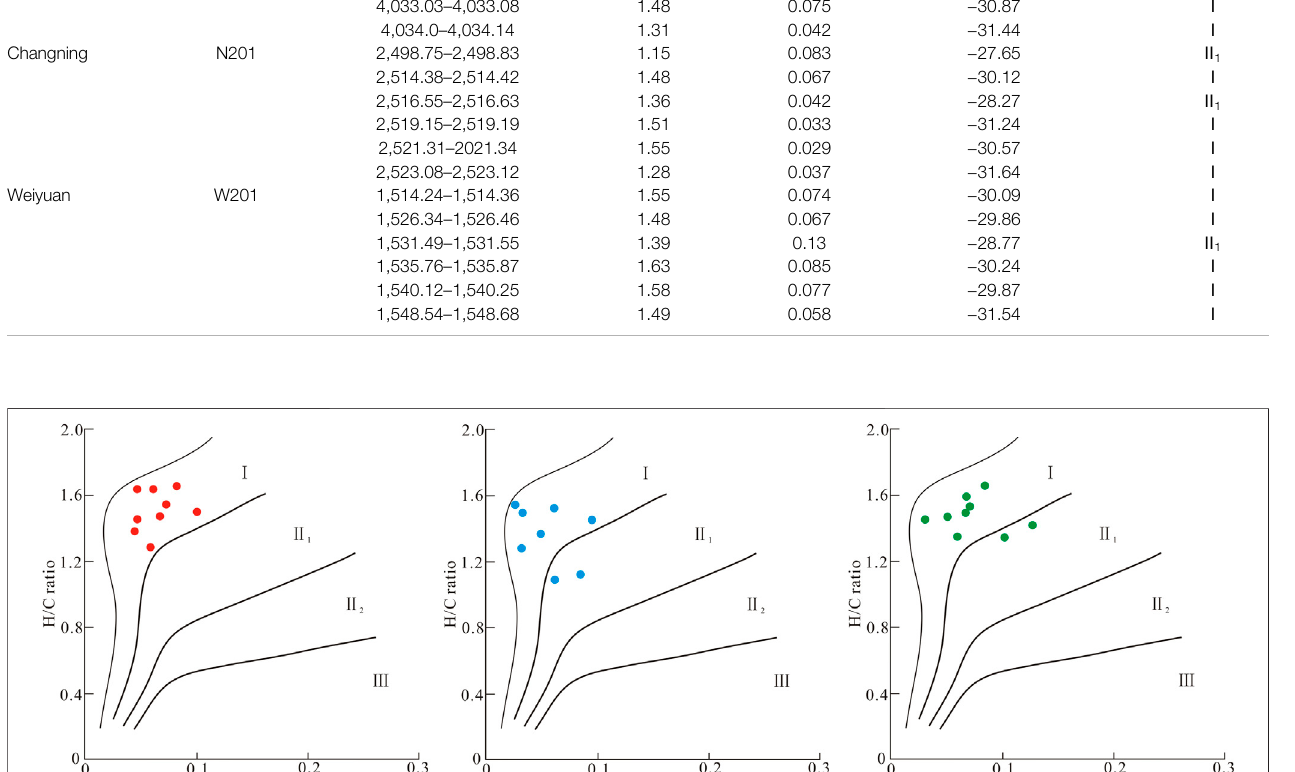
Frontiers in Earth Science |